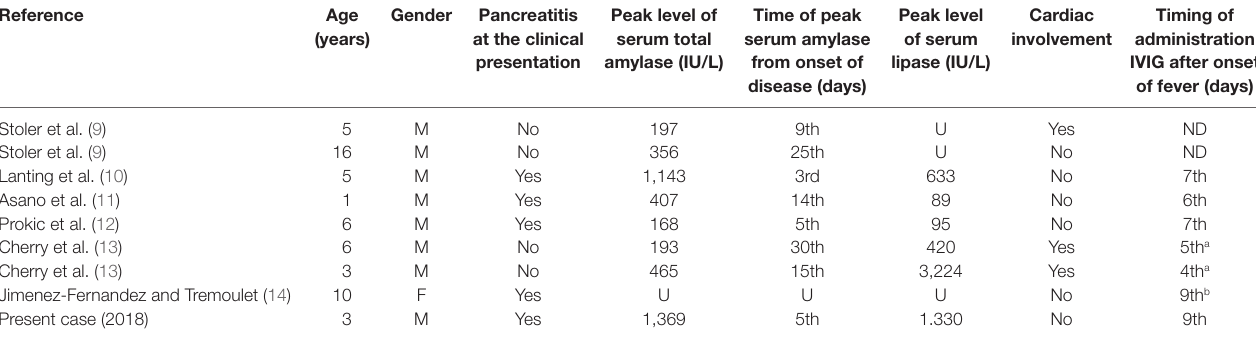
taBLe 2 | Summary of published data on Kawasaki disease with pancreatitic involvement (case reports).